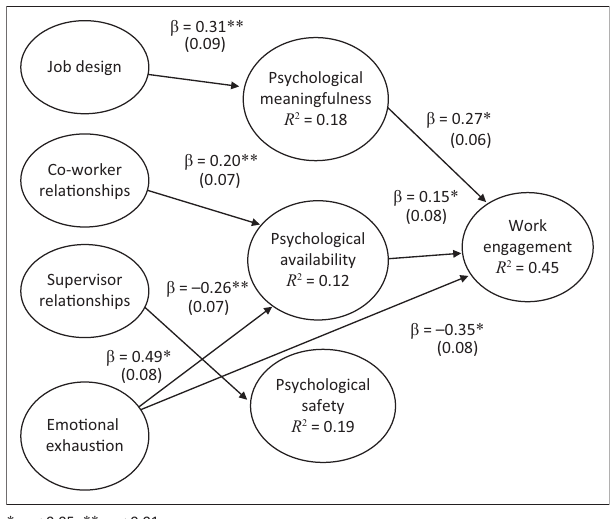
FIGURE 1: The final structural